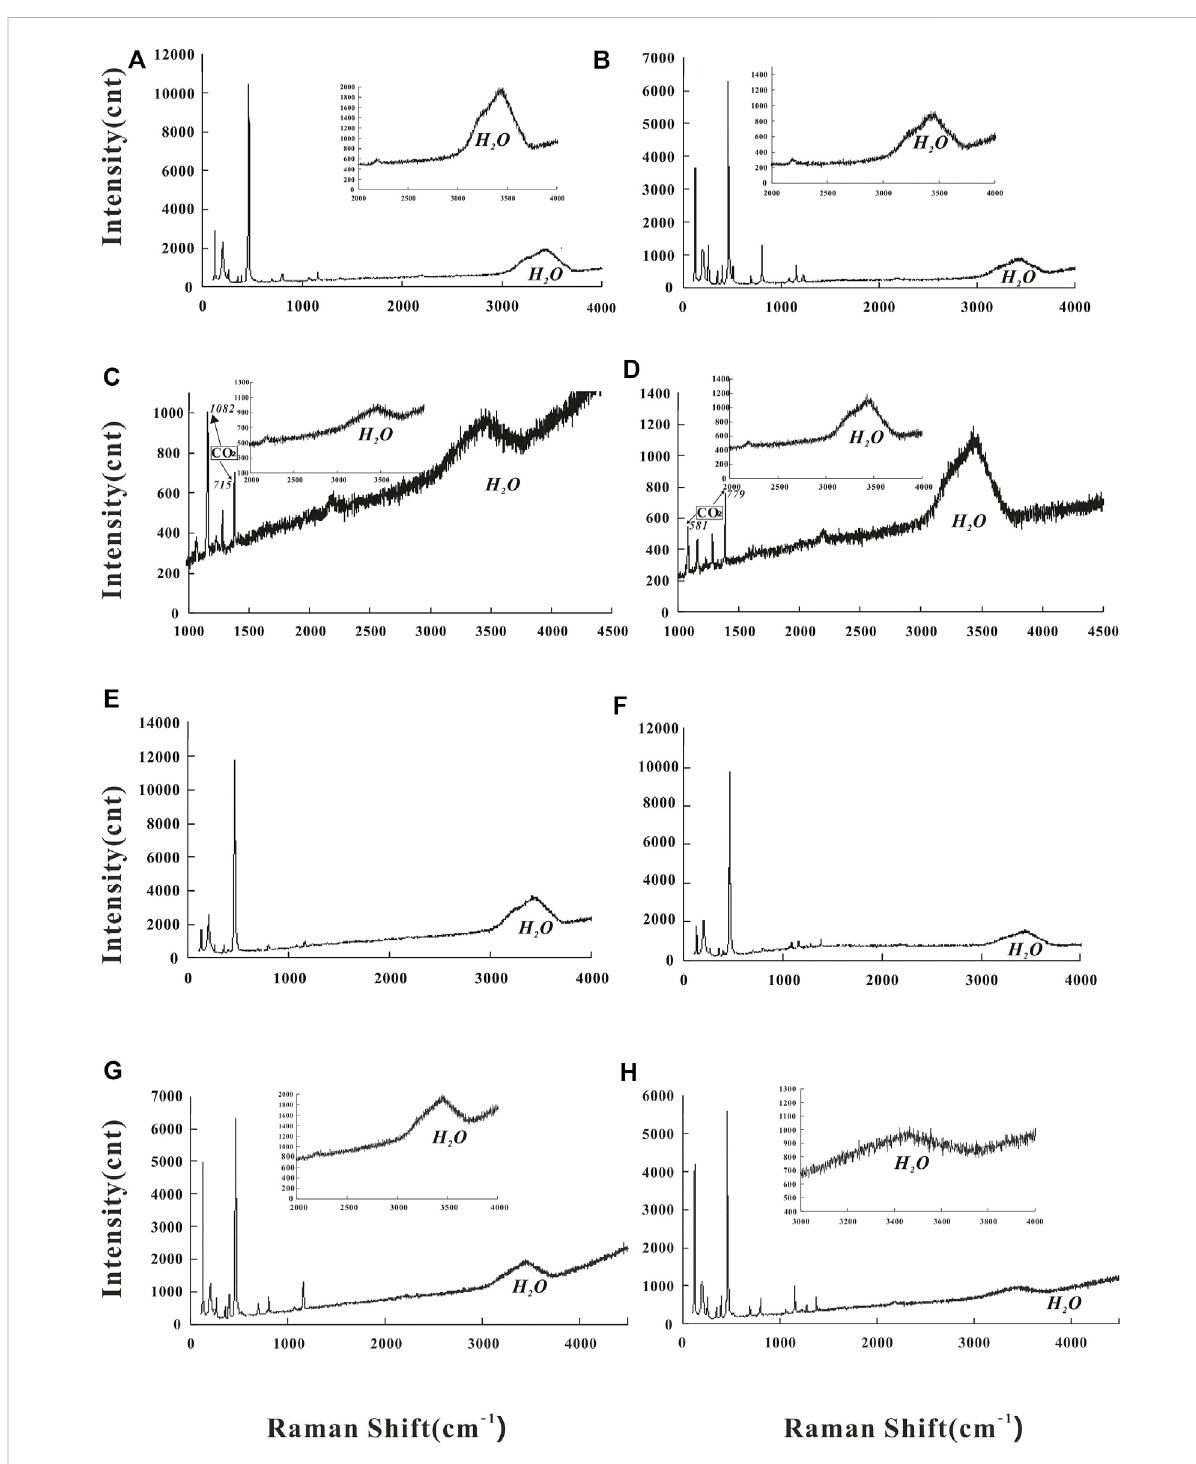
FIGURE 8 Representative laser Raman spectra for fl uid inclusions from the Shibaogou Mo – Pb – Zn deposit. (A) H-type fl uid inclusion in the anhydrous skarn stage I; (B) L-type fl uid inclusion in the hydrous skarn stage I; (C) C-type fl uid inclusion in the quartz – molybdenite stage II; (D) C-type and L-type fl uid inclusion in the quartz – sul fi de stage II; (E,F) L-type fl uid inclusion in the quartz – galena – sphalerite stage III; (F) L-type fl uid inclusion in the carbonate stage IV; and (G,H) L-type fl uid inclusion in the carbonate stage